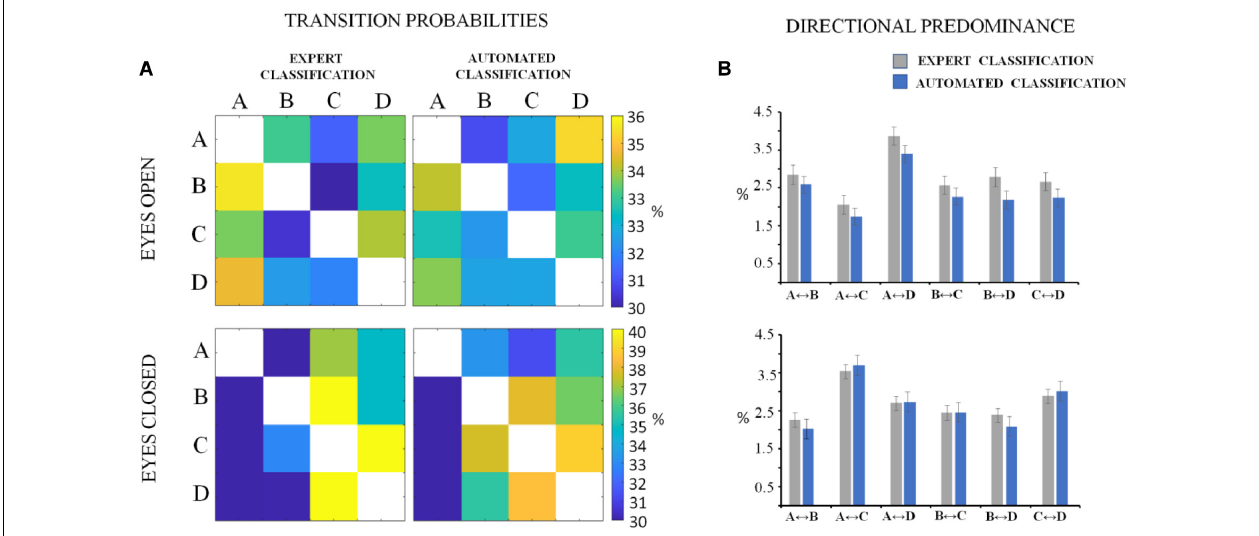
FIGURE 5 | Matrices of transition probabilities in the eyes open and eyes closed conditions (A) . The ij element of the matrix corresponds to the probability to transit from microstate i to microstate j . In (B) , the descriptive statistics of absolute values of directional predominance (mean values with standard errors) are shown. The labels of the directional predominance types are given in the X